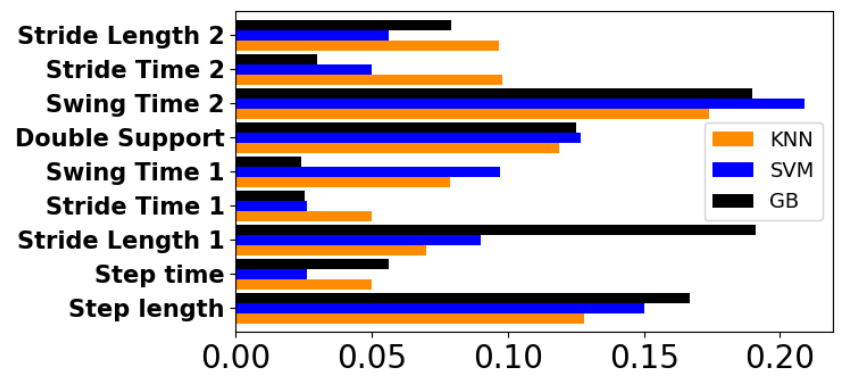
Figure 11. Feature importance of the KNN, SVM and GB models. For some features, the number assignation refers to a single foot.